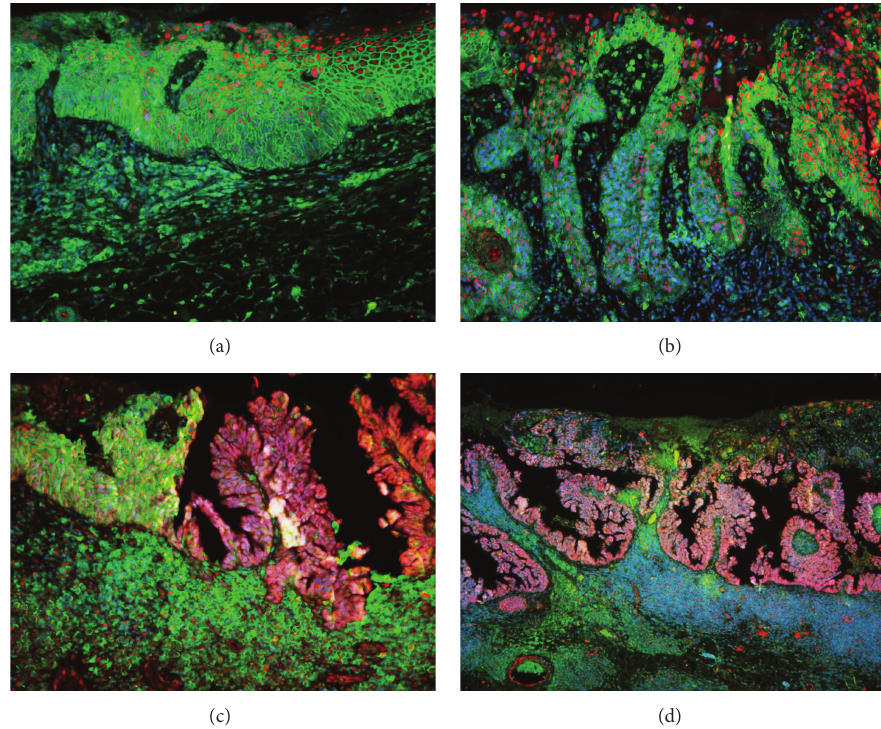
Figure 3: Fluorescence microscopy analysis of the staminal property of syringocystadenocarcinoma papilliferum. Immunofluorescent staining demonstrates anti-CD133 (in red) and anti-CD44 (in green) antibodies; the nuclei are contrasted by DAPI (in blue). (a) The tumoral squamous portion shows membranous CD44 overexpression (original magnification × 200). (b) The transition area presents squamous budding with decreasing of CD44 positivity but increasing of nuclear-cytoplasmic CD133 expression (original magnification × 200). (c) Bifront-like staining showing CD44 more represented in the squamous area and CD133 stronger in the papillary component (original magnification × 200). (d) Overview of CD133 positive-cystic and papillary structures (original magnification ×